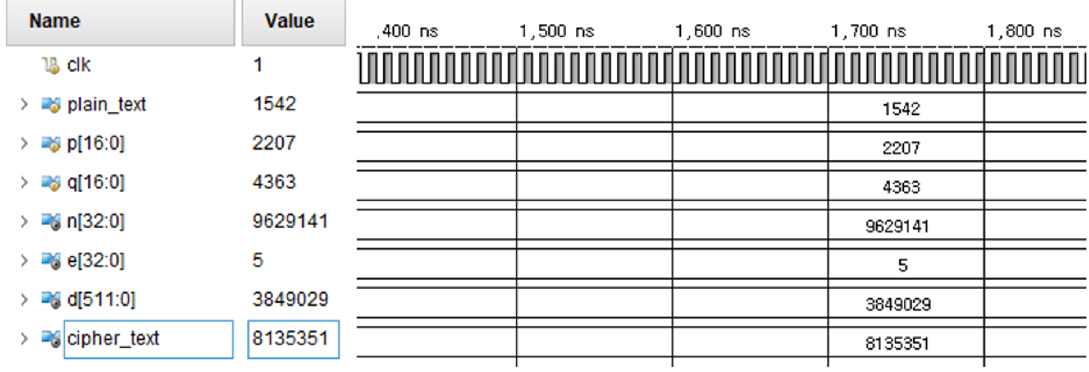
Figure 7. Encryption simulation results.